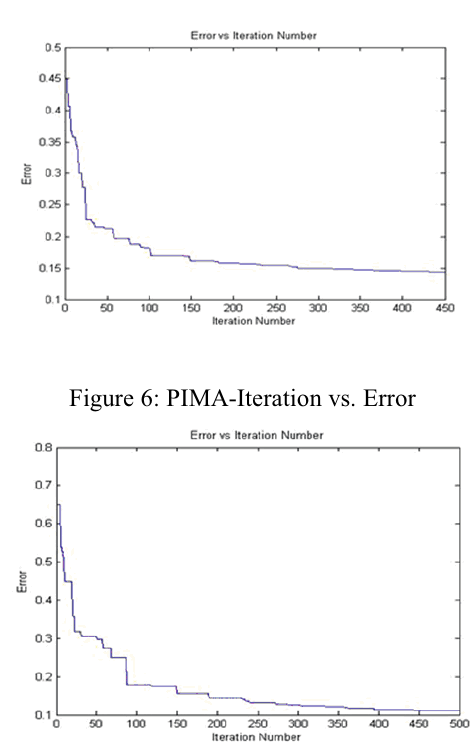
Table 6: Results Obtained From DE-FLANN for Ionosphere Dataset Numb